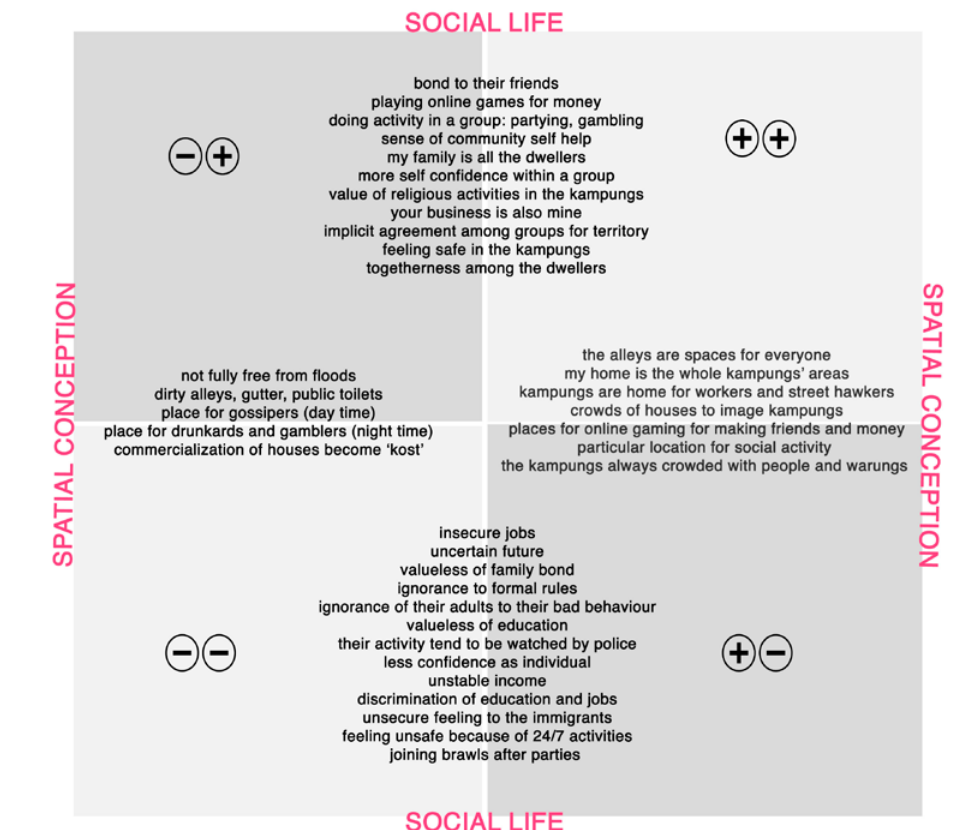
fig. 7. The young adults’ social life and spatial